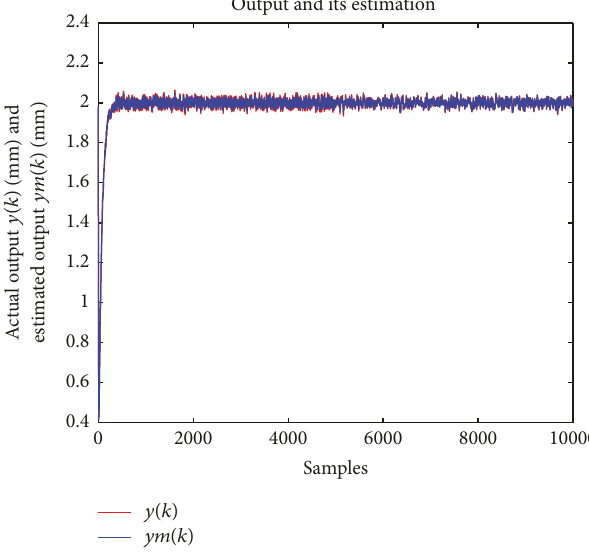
Figure 9: Measured and estimated output 𝑦(𝑘)